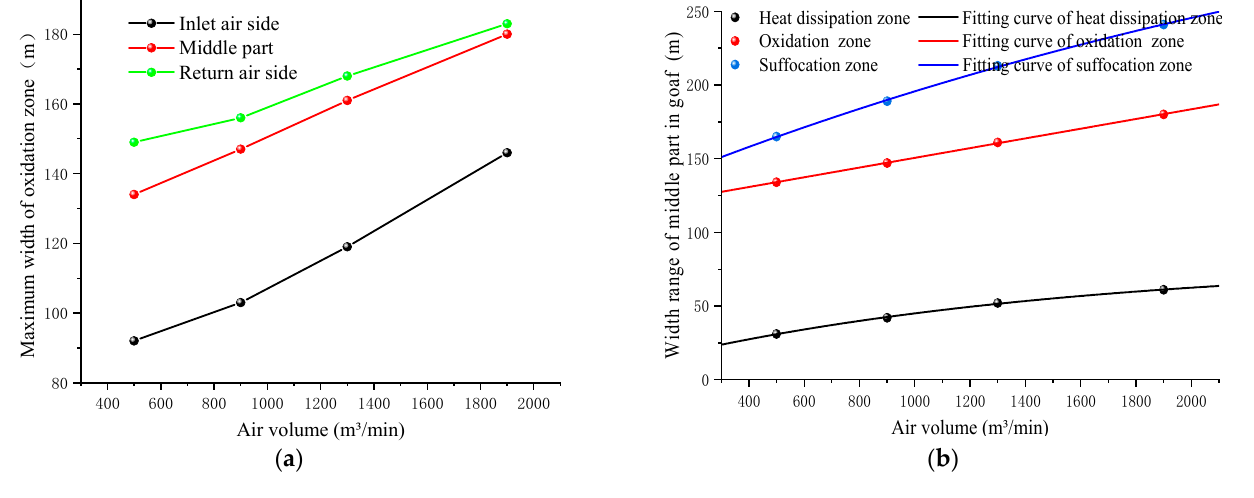
Figure 7. Distribution of the three zones in the goaf against the air volume. ( a ) Distribution of the maximum width of the oxidation zone against the air volume, ( b ) distribution of three zones in the goaf against the air